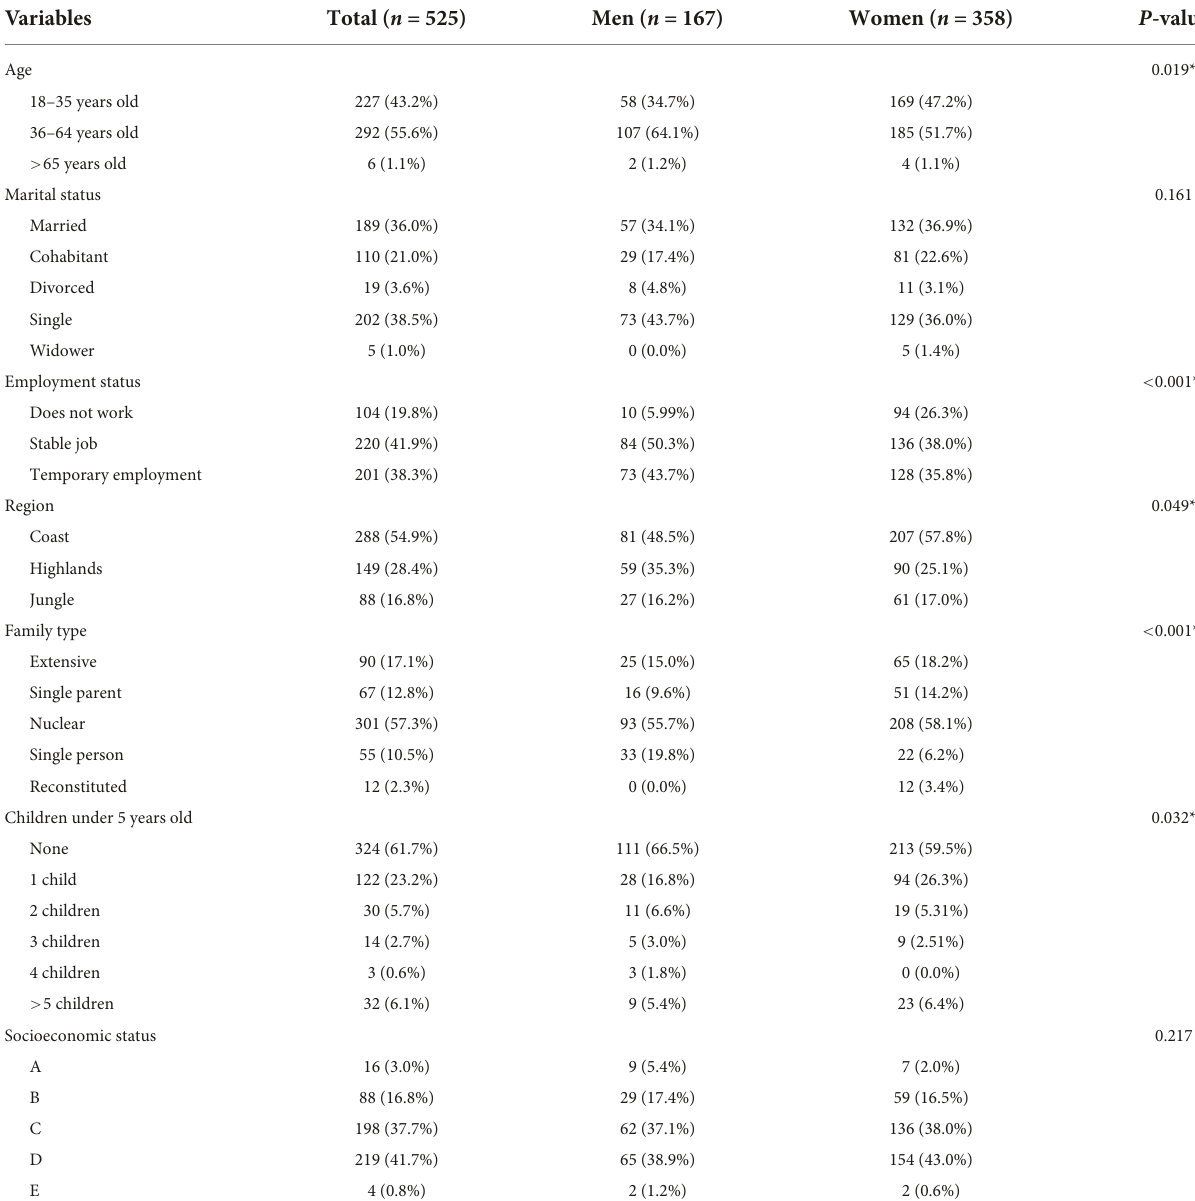
TABLE 1 General characteristics of the